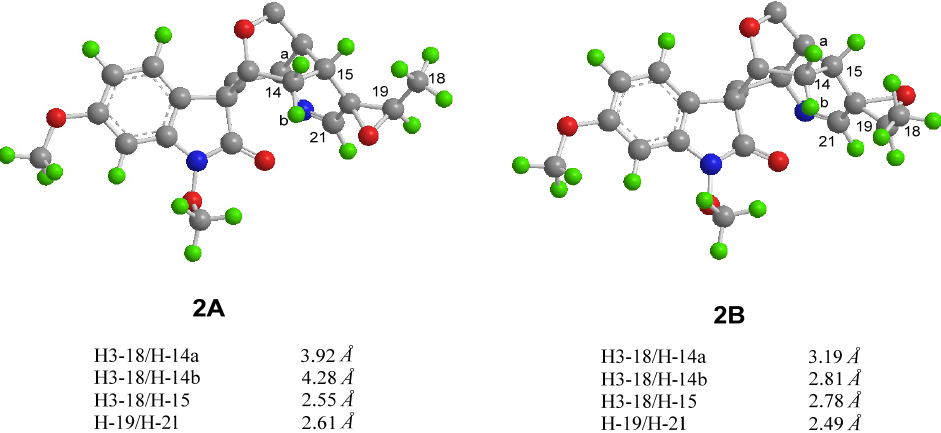
Figure 5. Calculated interproton distances near the epoxide for the two possible structures ( 2A and 2B ) of compound 2 .